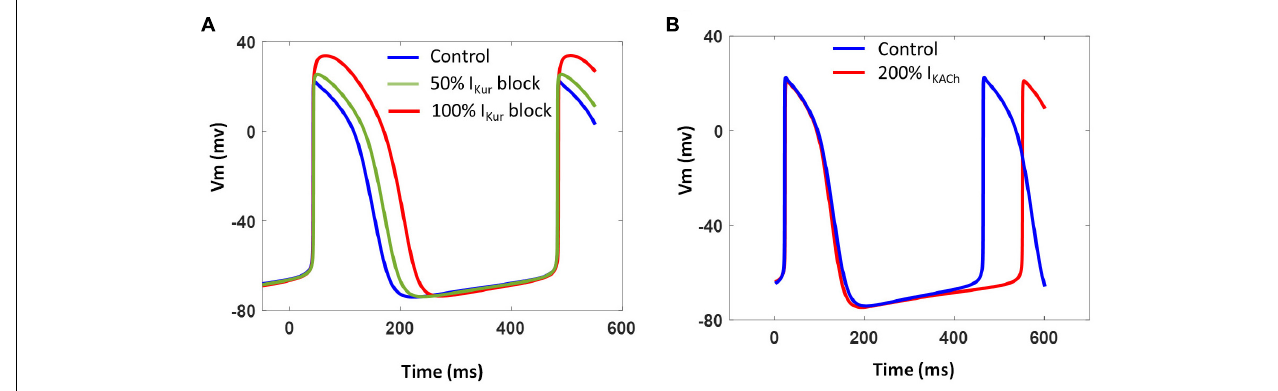
FIGURE 11 | (A) Effect of varying extent of I Kur block on model AP and CL. (B) Effect of I KACh enhancement on model AP and CL.